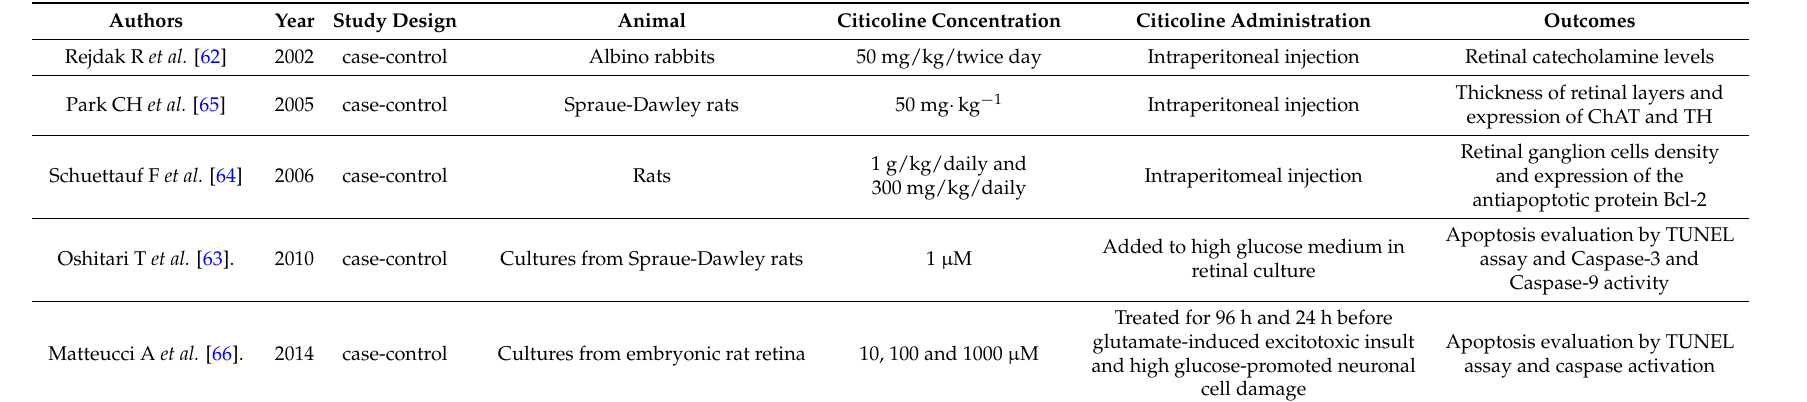
Table 1. Experimental